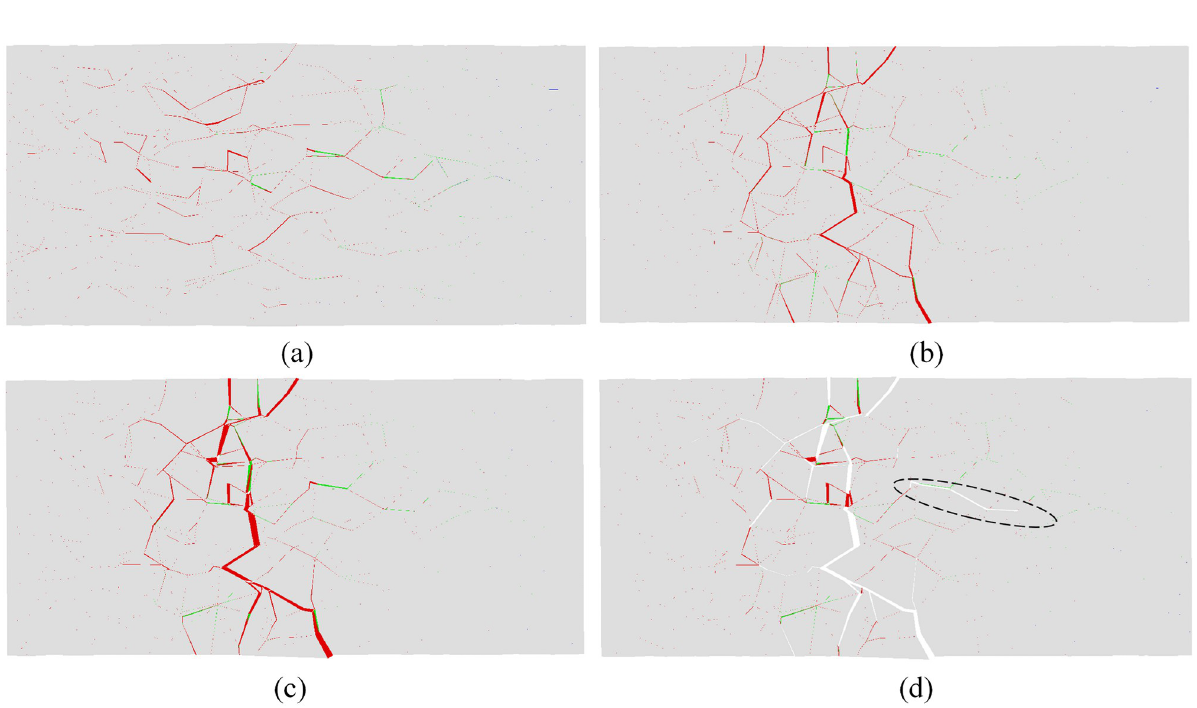
Fig 11. Progressive fracture process of the slice at a velocity of 25.0 m/s (the left face is the impacting face, and the red and green traces depict the cohesive element that has been deleted mainly due to shear failure and tensile failure, respectively): (a) at 0.1 ms; (b) at 0.2 ms; (c) at 0.25 ms; (d) at 0.25 ms, the deleted cohesive elements are not